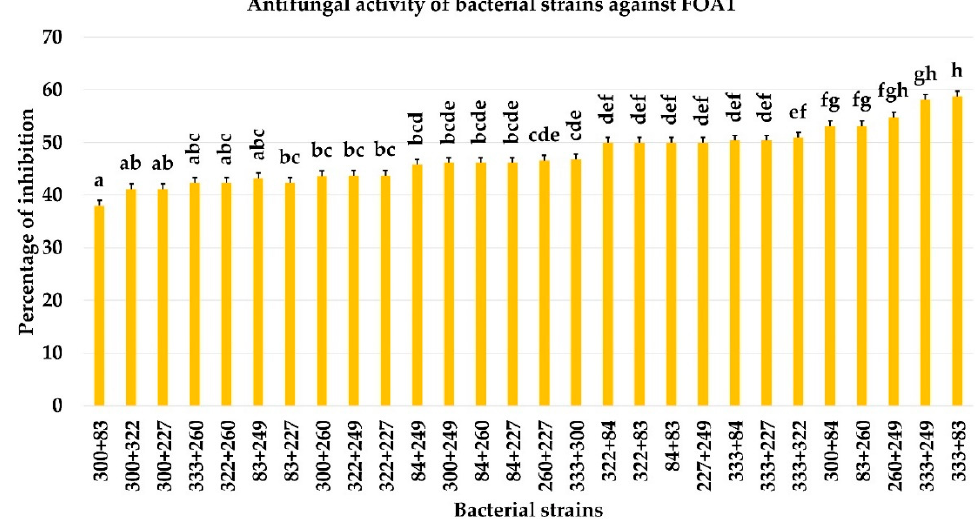
Figure 6. Percentage of inhibition of combined bacterial strains against FOA1. Data shown are the means ± the standard error. Different letters between bars in each group indicate a significant dif- ference at ( p < 0.05) determined by ANOVA with the comparison of means using Tukey’s HSD.